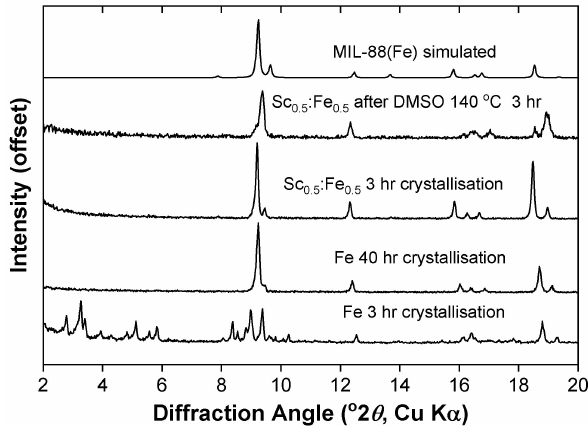
Figure 4. Powder X-ray di ff raction patterns of MOFs transformation from MIL-101(Fe), 3 hour crystallisation) to MIL-88B(Fe), 40 hour crystallisation, along with mixed (Fe,Sc) (nominal metals ratio 1:1), 3 hour crystallisation. The second from top pattern illustrates the stability of the mixed-metal phase on heating in